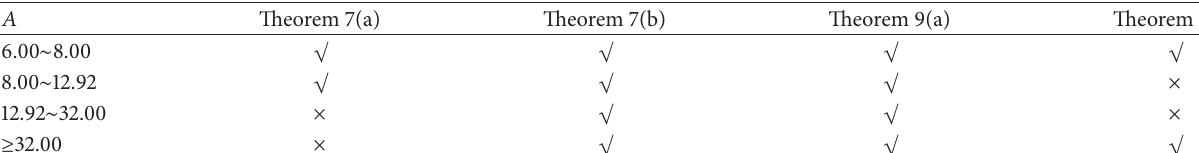
Table 1: Applicability of conclusions in Theorems 7 and 9 under the case of 𝐴 > 𝑤𝑏 .